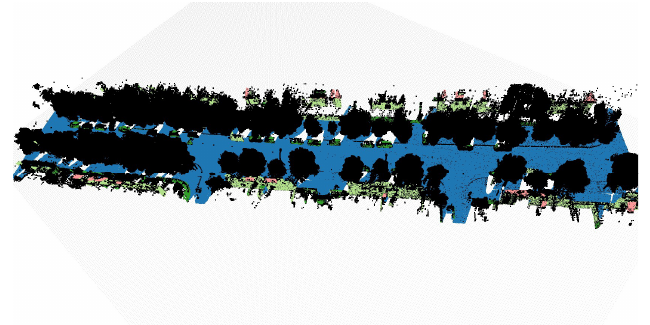
Figure 2. An illustration of rule-based planar region growing with all the non-planar points assigned to